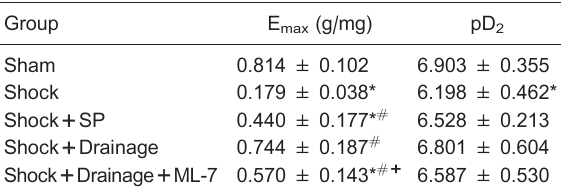
Table 2. Influence of mesenteric lymph drainage on E max and pD 2 of vascular response to calcium in rats following hemorrhagic